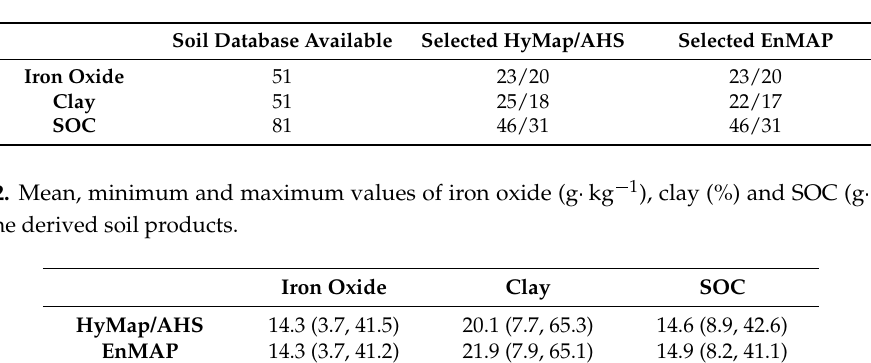
Table 1. Available ground truth soil database: Total number of samples available, and resulting number of soil samples selected for calibration/validation, as derived from selection of bare pixels and random stratified sampling.